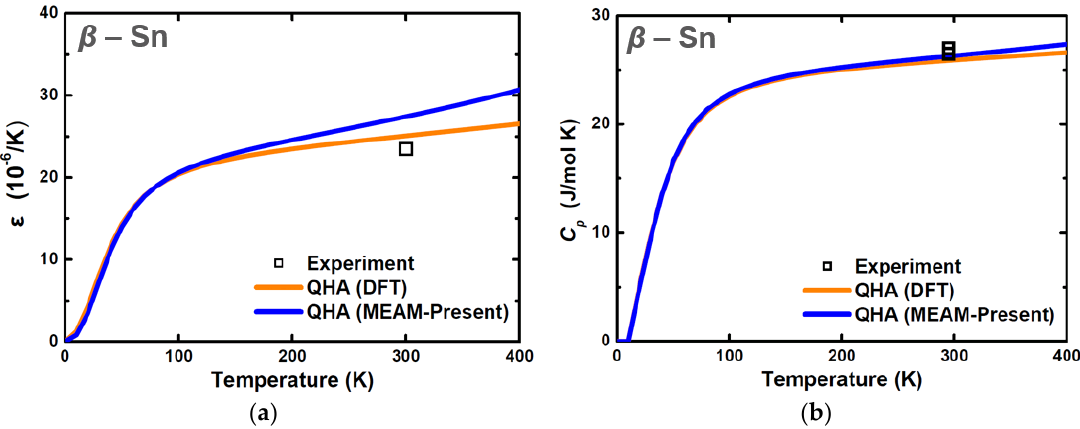
Figure 5. ( a ) Thermal expansion coefficient ( ε ) and ( b ) heat capacity ( C P ) of β -Sn, calculated based on the quasiharmonic approximation (QHA). The results using the present 2NN MEAM potential are compared with those using the present DFT calculation and experimental data (Refs. [43,48]).